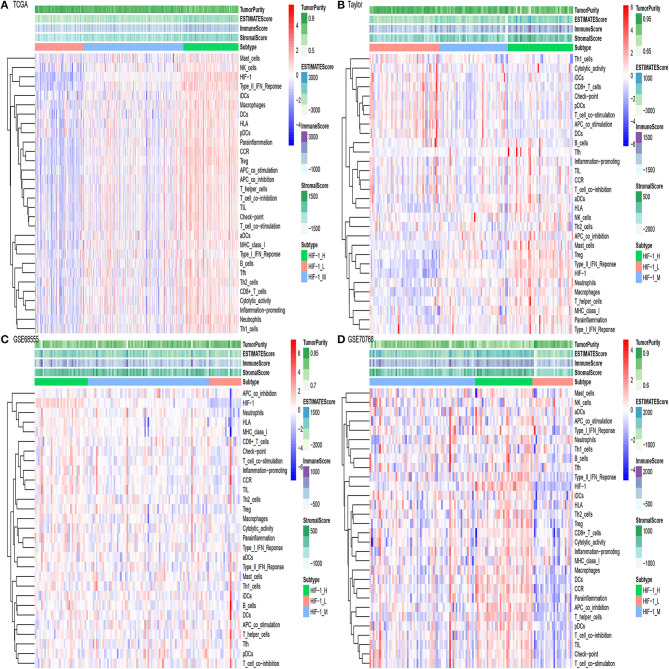
The hierarchical clustering of PCa exhibits three clusters in four different datasets. (A–D) TCGA PCa, Taylor, GSE68555, and GSE70768.